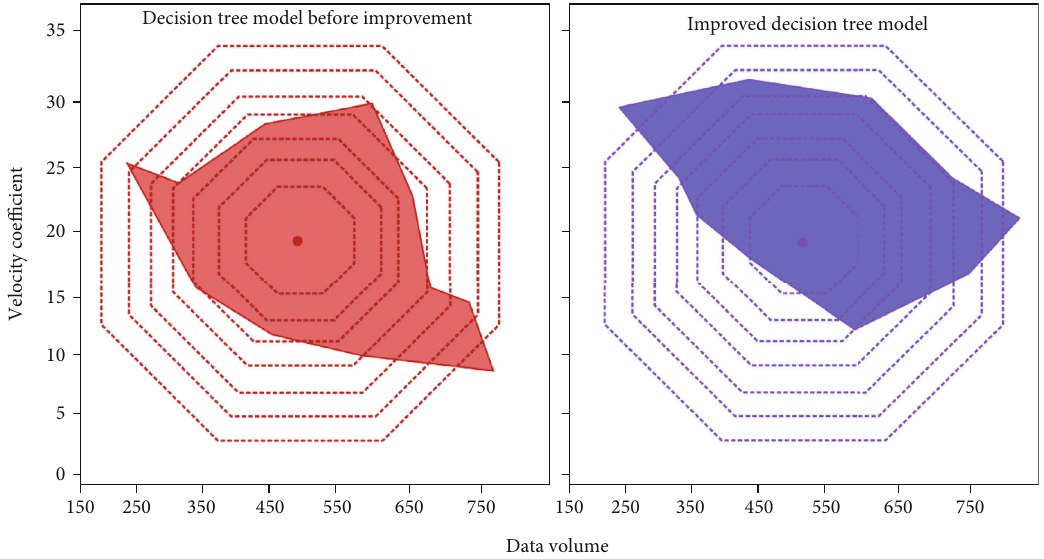
Figure 8: The change of speed range of decision tree model in data processing before and after